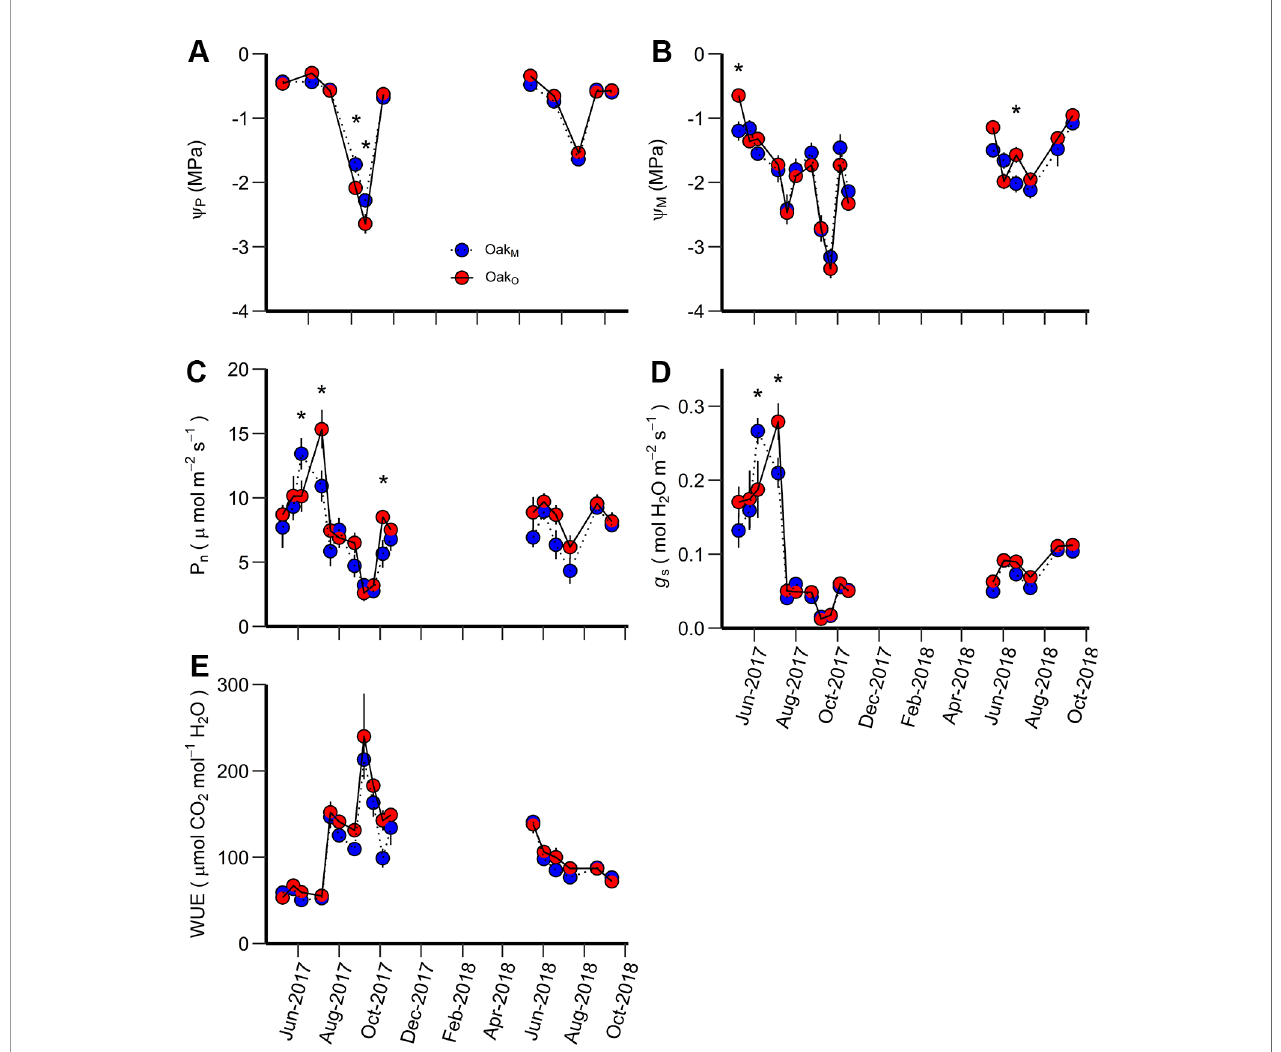
FIGURE 3 | Predawn water potential ( Y P ) (A) , midday water potential ( Y M ) (B) , net photosynthetic rate (P n ) (C) , stomatal conductance (g s ) (D) , and water use ef fi ciency (WUE) (E) measured during the study period for Oak M vs. Oak O . Oak M are post oak trees growing in a mixed-species stand while Oak O are post oak growing in single-species stands. An asterisk (*) indicates signi fi cant differences on speci fi c dates (p < 0.05). Vertical bars represent standard errors of measurements at each date (not shown when smaller than the symbol